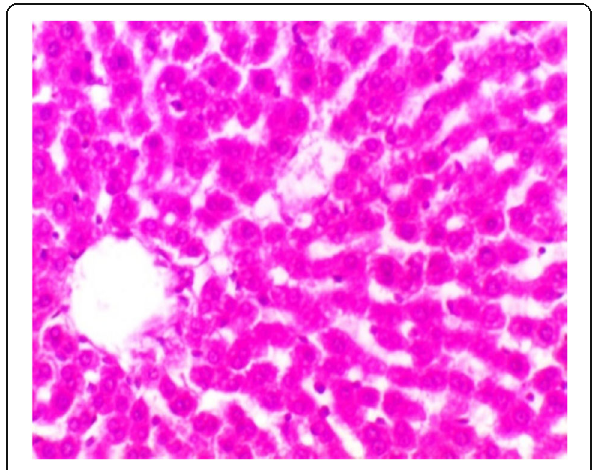
Fig. 9 Photomicrograph of the liver section after NAC treatment 1 week before CCl4 showing improvement in the liver architecture (H&E; × 400)